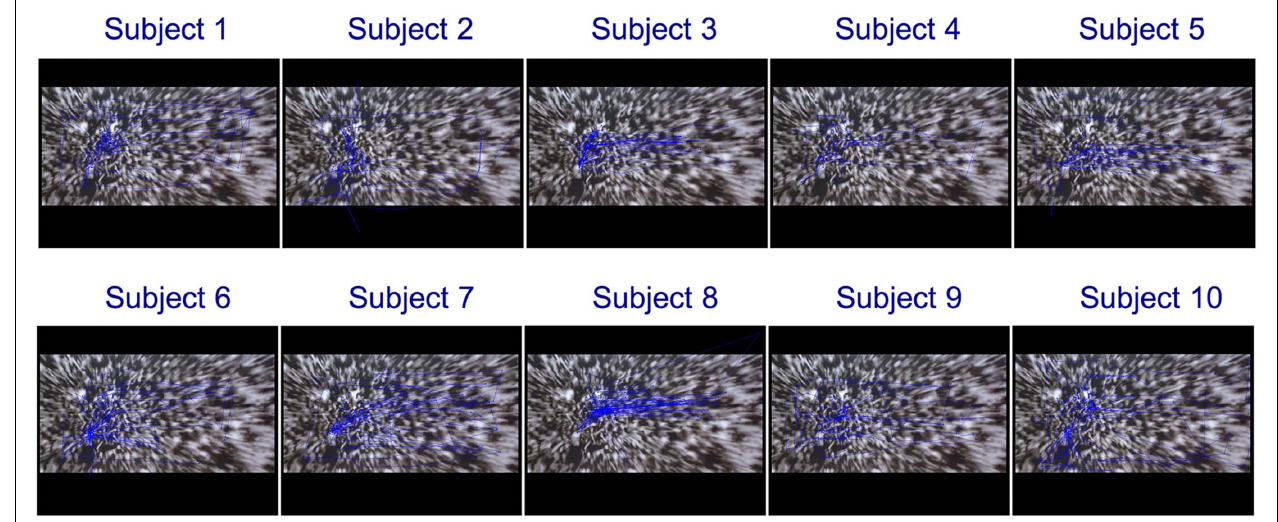
FIGUREA1 | Saccade patterns for all 10 subjects looking at “center of gaze,” by Mariano Molina.